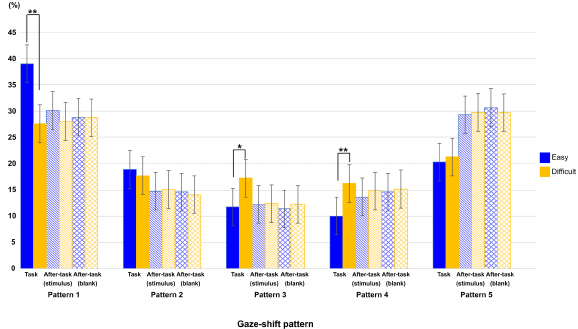
Figure-06 . Ratio of each type of eye-shift pattern in each phase for both task-difficulty levels. Error bars indicate 95% confi- dential interval based on Loftus, G. R. and Masson, M.